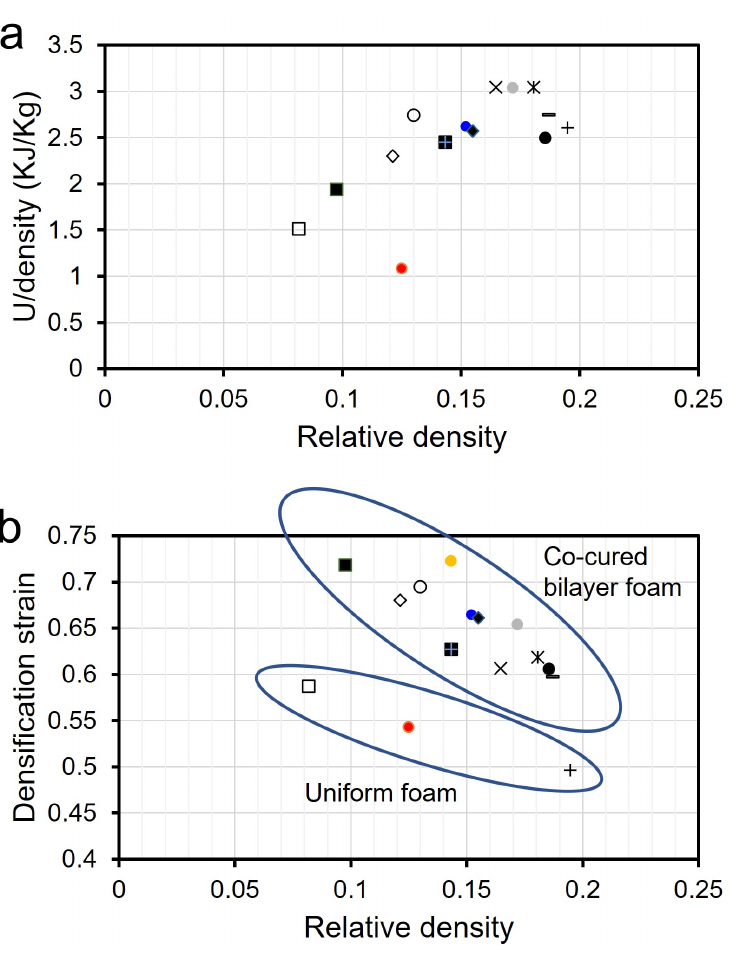
Figure 5. ( a ) Specific energy absorption ( U ρ ) of uniform and bilayer foams as a function of relative density. ( b ) densification strain ( (cid:101) d ) of uniform and bilayer foams as a function of relative density.